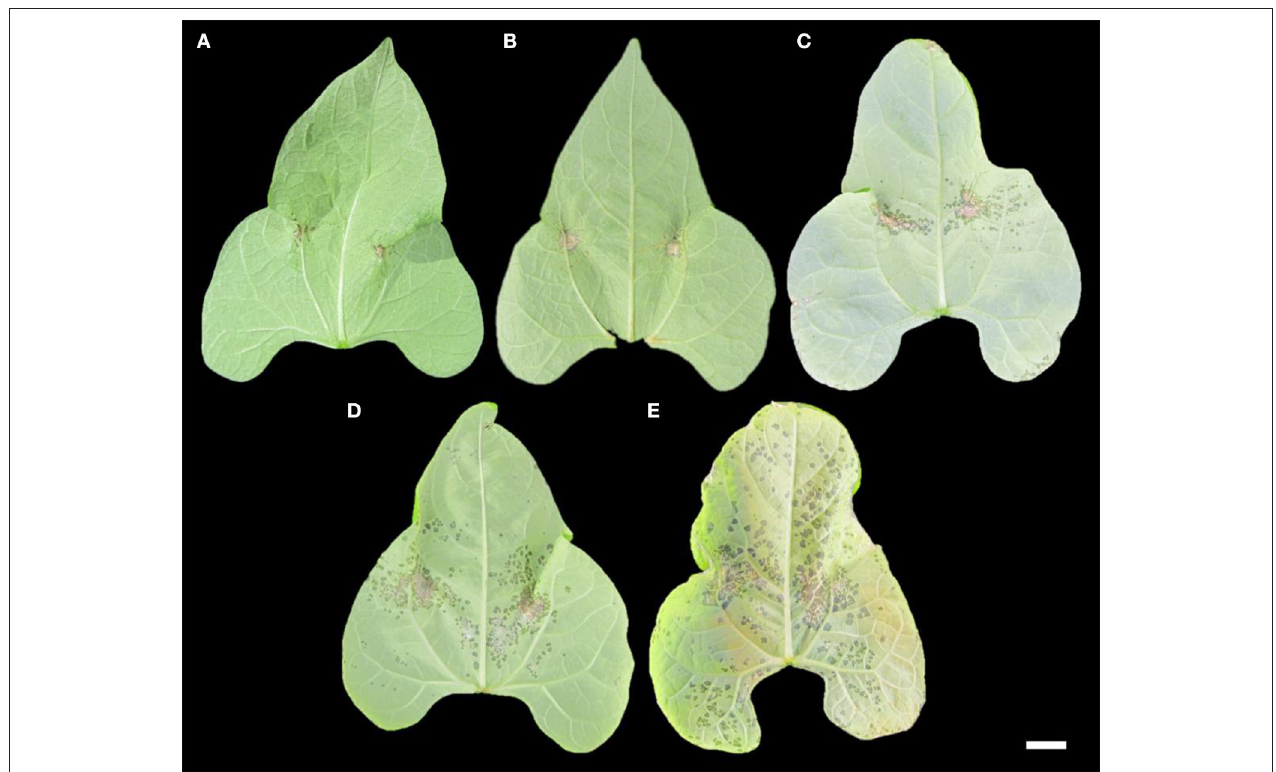
FIGURE 1 | Interaction phenotypes exhibited by different Phaseolus vulgaris genotypes 10 days after inoculation with Pseudomonas syringae pv. phaseolicola Race 6 or Race 1, including (A) Red Mexican UI-3 (disease score = 1.0; highly resistant), (B) Edmund (disease score = 2.0; resistant), (C) SOA-BN × Edmund recombinant inbred line 113 (disease score = 3.0; slightly susceptible), (D) SOA-BN × Edmund recombinant inbred line 22 (disease score = 4.0; susceptible), and (E) SOA-BN (disease score = 5.0; fully susceptible). Scale bar: